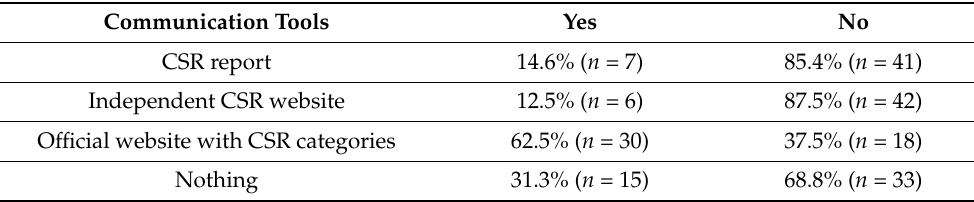
Table 4. Communication tool for CSR